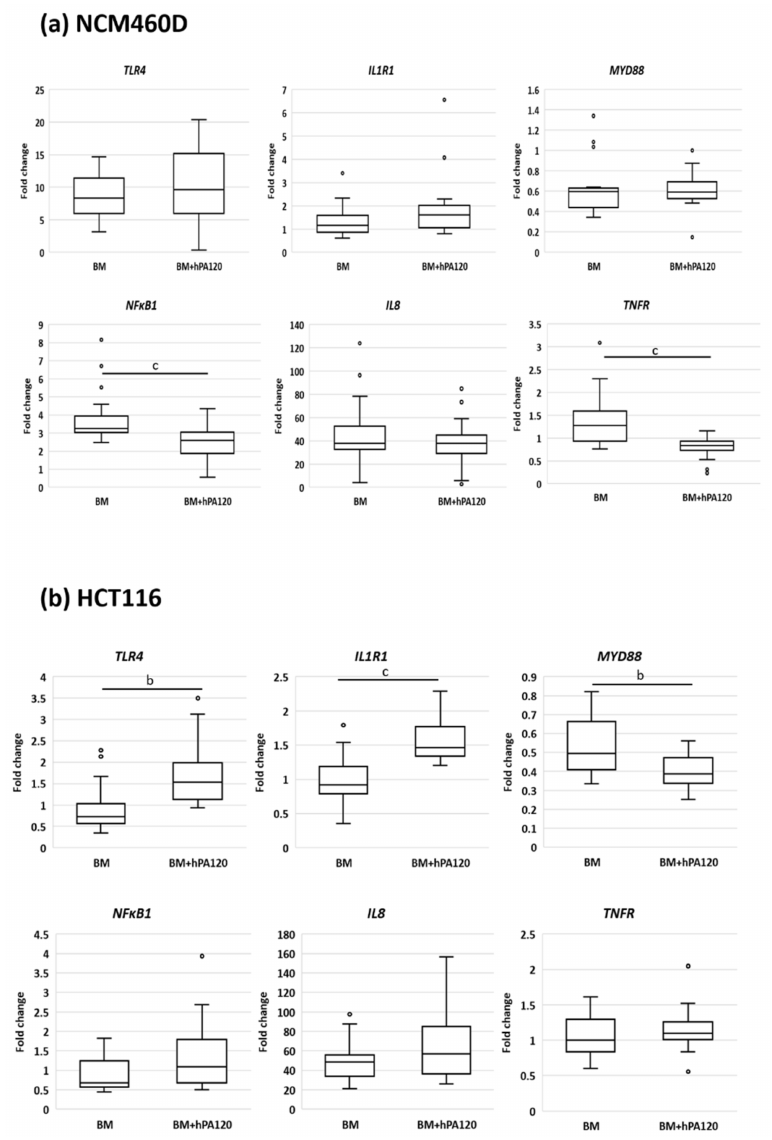
Figure 8. Comparison of the effect of the phytate hydrolysate (hPA120) on gene expression in bacteria- treated ( a )—healthy (NCM460D) and ( b )—cancer (HCT116) colonocytes. Fecal bacteria derived